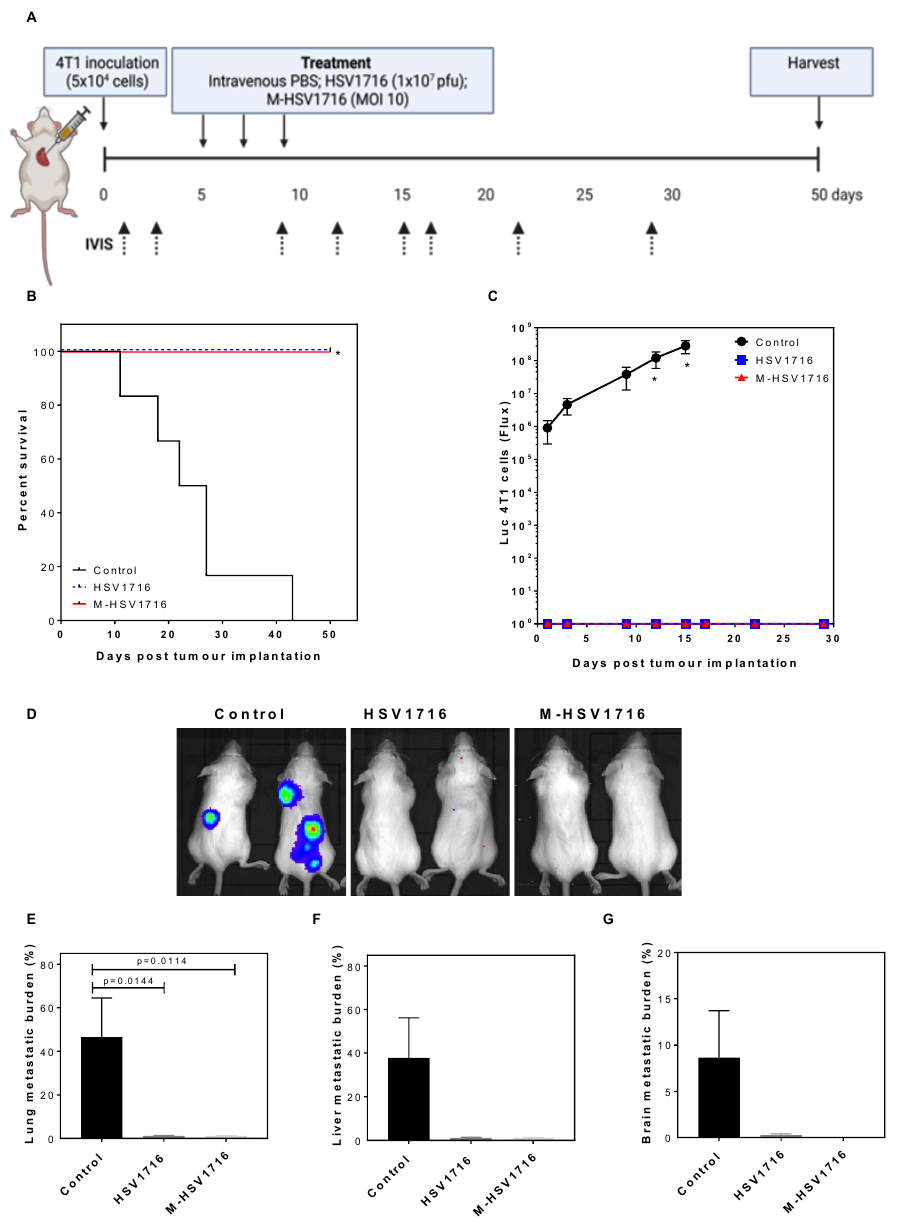
Figure 3. M-HSV1716 is equivalent to intravenous HSV in an early metastatic model. Luciferase- labeled 4T1 cells were injected into the left ventricle of the heart via intracardiac injection of female Balb/C mice. At days 5, 7 and 9, mice were treated with PBS, HSV1716 (1 × 10 7 pfu/mL) or M-HSV1716 ((1 × 10 6 macrophages infected at MOI 10), and the development of metastases was monitored by IVIS up to day 50 ( A ). M-HSV1716 provided a survival advantage ( B , Log-Rank test) corresponding with an absence of visible metastatic disease quantified by flux analysis of luciferase- expressing 4T1 cells ( C , D ). The burden of metastases was calculated as the percentage of the organ with metastatic involvement calculated as an average of 2–4 different sections of lung ( E ), liver ( F ) and brain ( G ), over 100 um apart from 2–4 slides. Data shown are mean ± SEM, n = 4–6 animals. Panel A was created with BioRender.com, accessed on 6 October 2022.